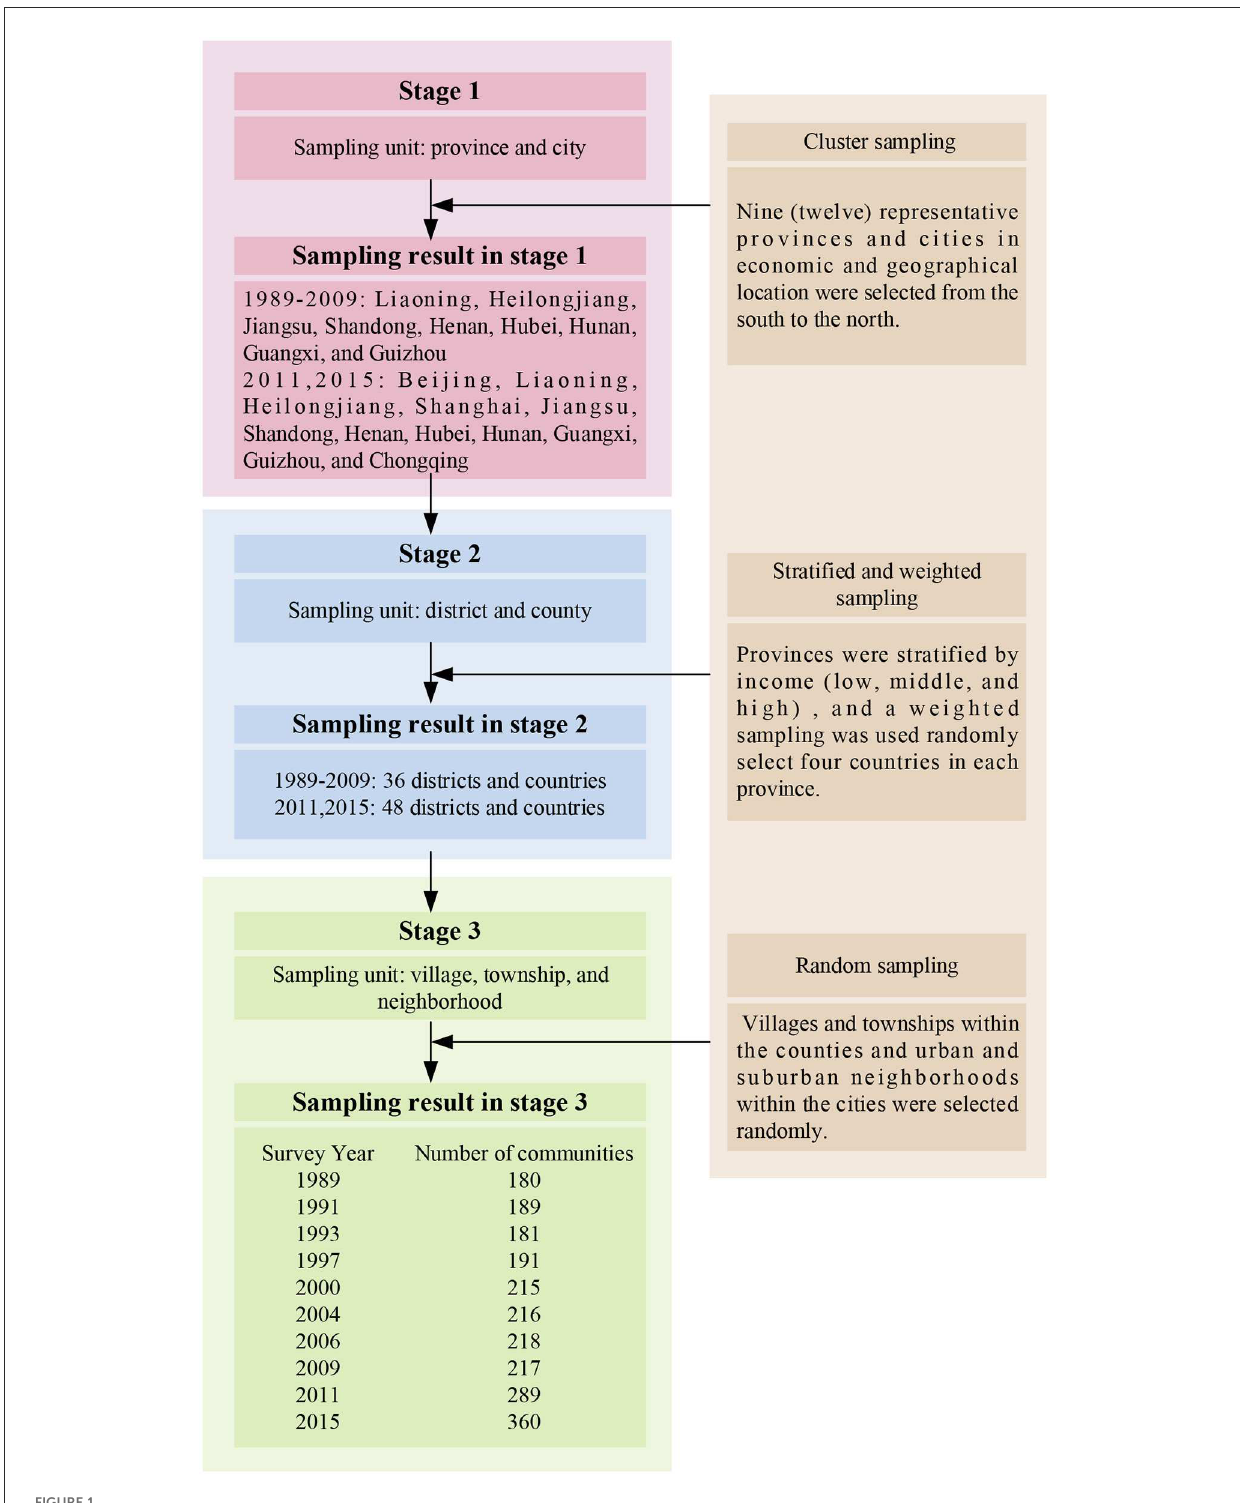
FIGURE1 Multistage random cluster sampling